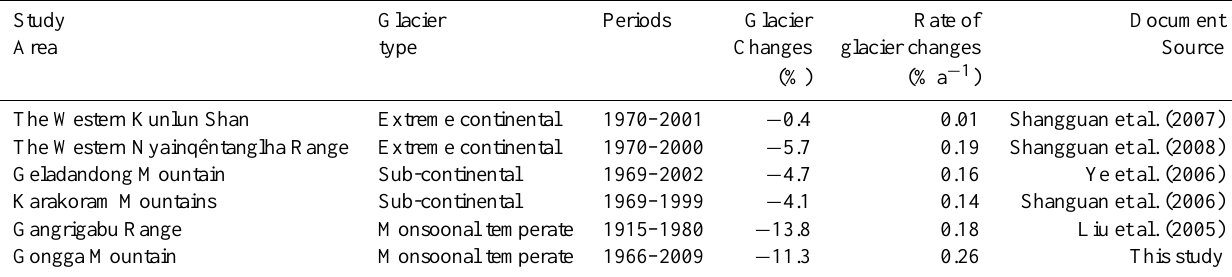
Table 7. The glacier changes of three types in China Study Glacier Periods Glacier Rate of Document Area type Changes glacier changes